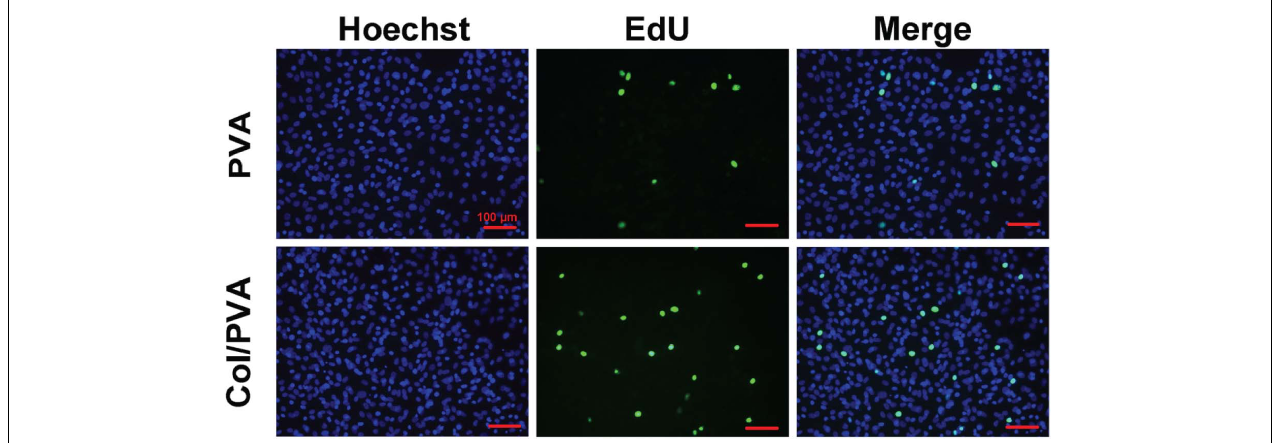
FIGURE 6 | Fluorescence images of BMSCs cultured on the pure PVA membrane and collagen layer of the Col/PVA dual-layer membrane (represented as Col/PVA) for 1 day. Hoechst staining with blue indicated the living cells on two surfaces and EdU staining with green indicated the active DNA duplicate activity of cells. The scale bar was 100 µ